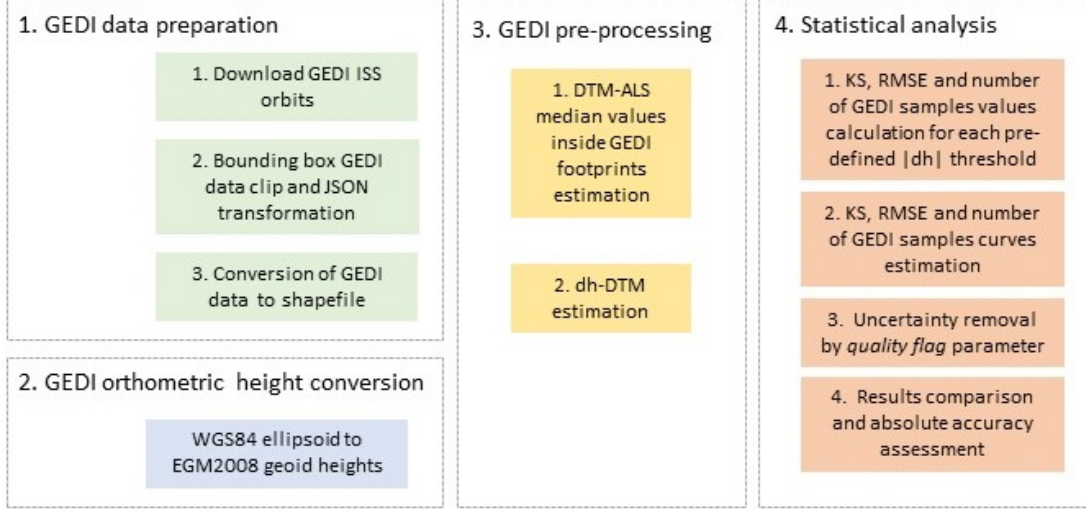
Figure 2. Methodological flowchart.